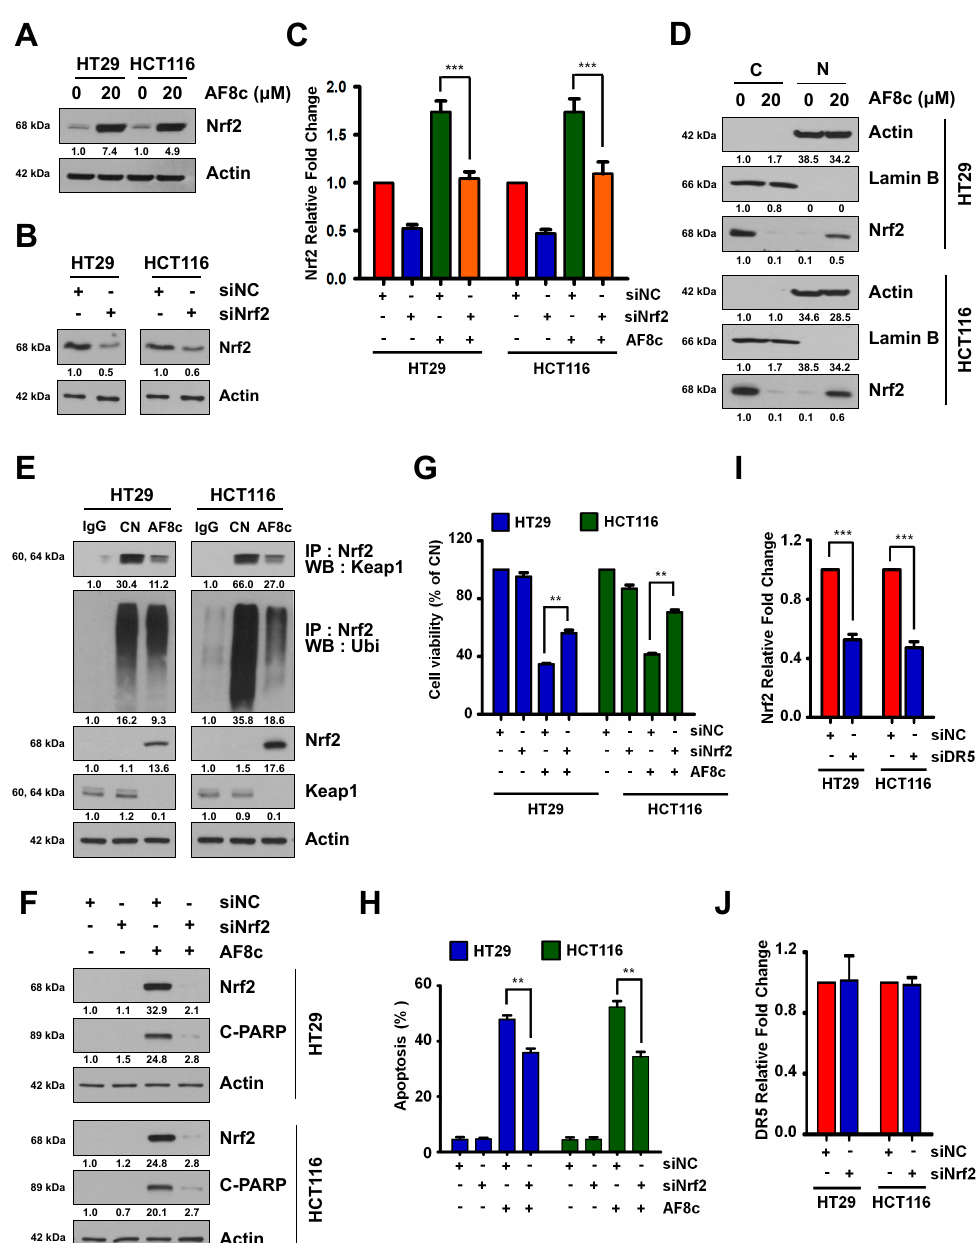
Figure 4. AF8c-induced apoptotic cell death is related to Nrf2 activation: ( A ) cells were incubated with 20 μ M AF8c, and the Nrf2 protein levels were monitored by Western blotting; ( B , C ) HT29 (left) and HCT116 (right) cells were transfected with siNC or siNrf2 and then treated with 20 μ M AF8c. The protein ( B ); and mRNA ( C ) expression levels of Nrf2 were subjected to qRT-PCR and Western blot; ( D ) AF8c-treated cells were fractionated, and Nrf2, Actin, and Lamin B were detected by immunoblotting: ( E ) after AF8c treatment, binding between Nrf2 and Keap1, and between Nrf2 and Ubiquitin was performed by immunoprecipitation; ( F – H ) after transfection with siNC or siNrf2, apoptosis resulting from AF8c treatment was analyzed by Western blotting ( F ); cell viability assay ( G ); and FACS analysis ( H ). **, p < 0.01. ( I ) Cells were transfected with siNC or siDR5, and the Nrf2 mRNA level was measured by qRT-PCR. ***, p < 0.001. ( J ) Cells were transfected with siNC or siNrf2, and DR5 mRNA levels were then confirmed by qRT-PCR.